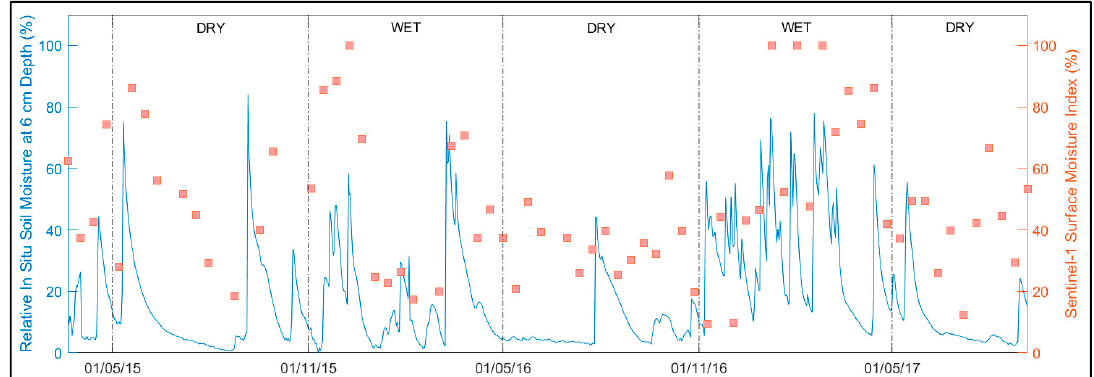
Figure 6. Relative in situ soil moisture information (blue line) and Sentinel-1-derived SurfMI (red dots) time series for the dry (May to October) and wet (November to April) seasons between 2015 and 2017.